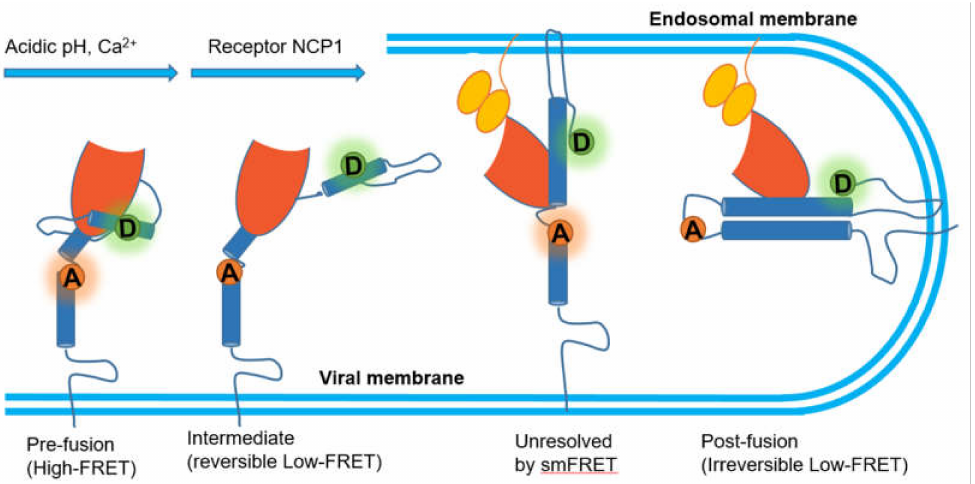
Figure 8. Mechanistic model of GP-mediated membrane